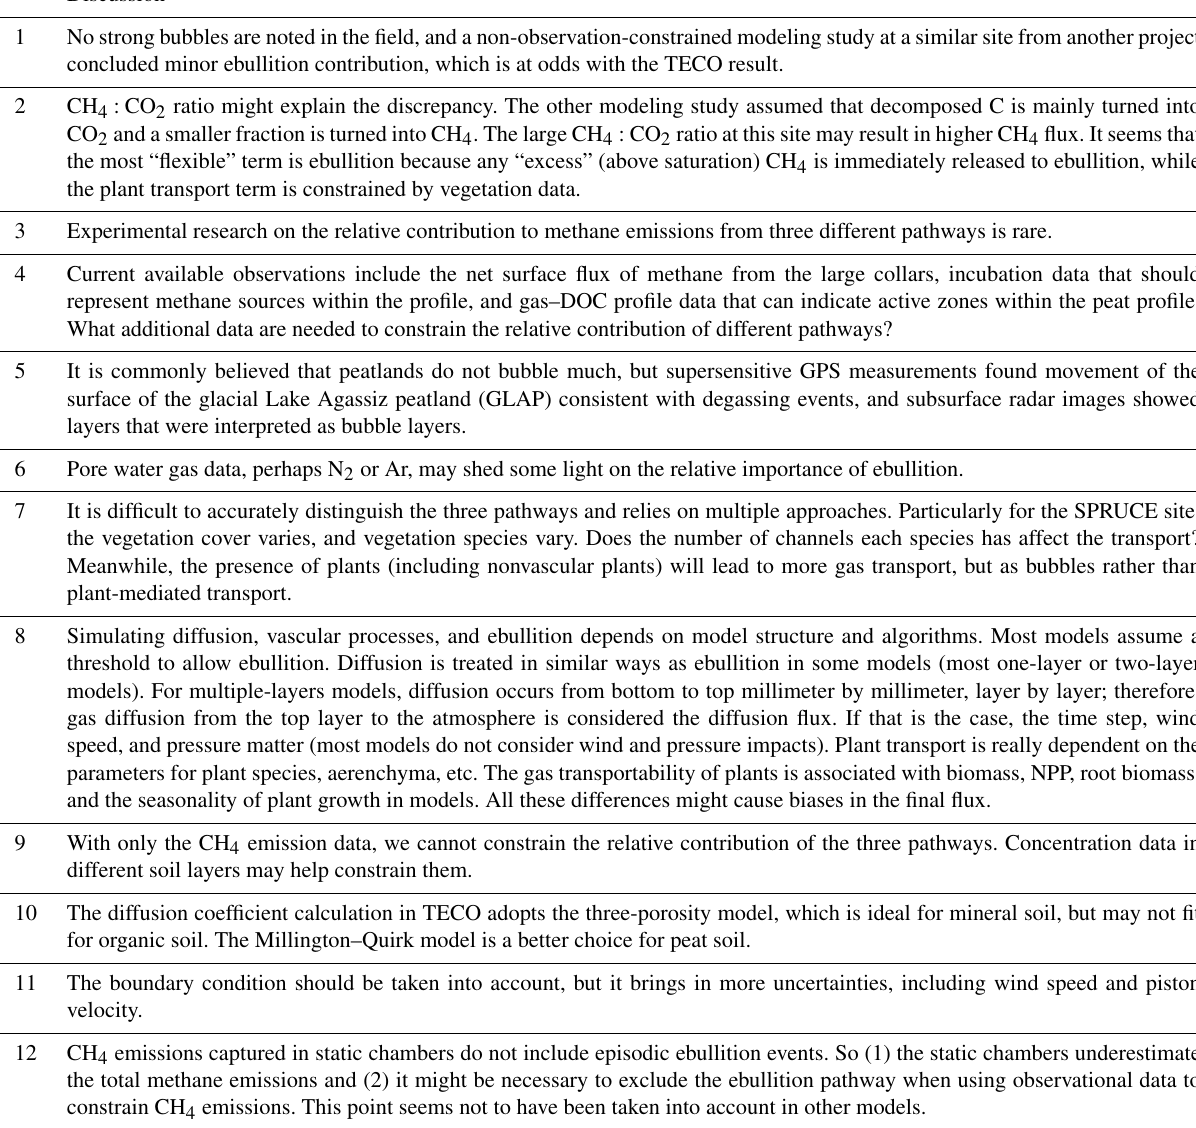
Table 1. Discussion stimulated by EcoPAD-SPRUCE forecasting among modelers and experimenters on how to improve predictions of the relative contribution of different pathways of methane